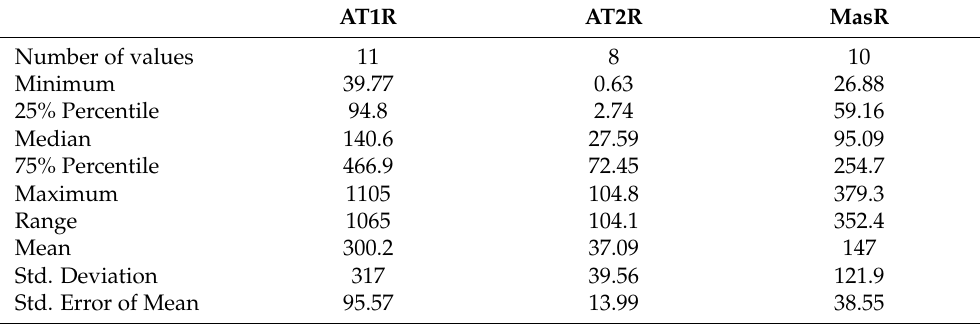
Table 2. AT1R , AT2R and MasR values obtained from ddPCR. Data are expressed as gene copies obtained from 25 ng of mRNA.